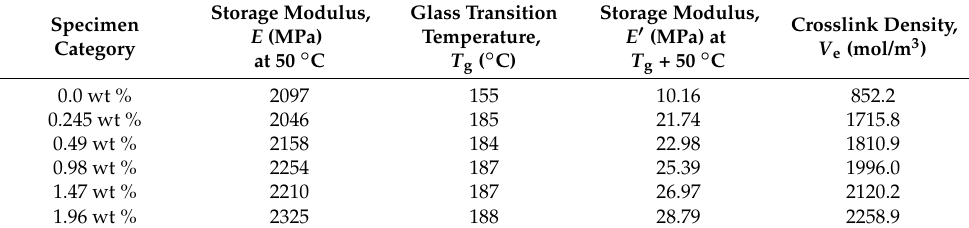
Figure 8. DSC curves of epoxy/GPLP composites.